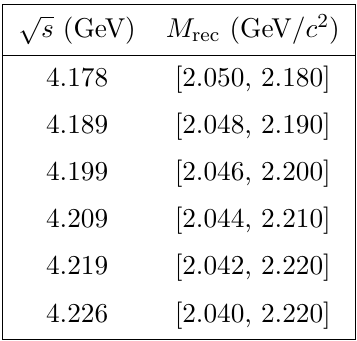
Table 3 . The requirements of M rec for each data